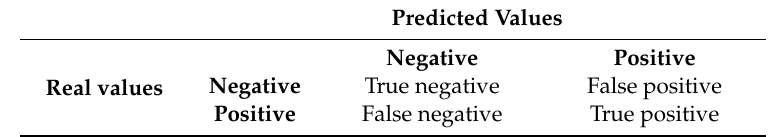
Table 6. Confusion